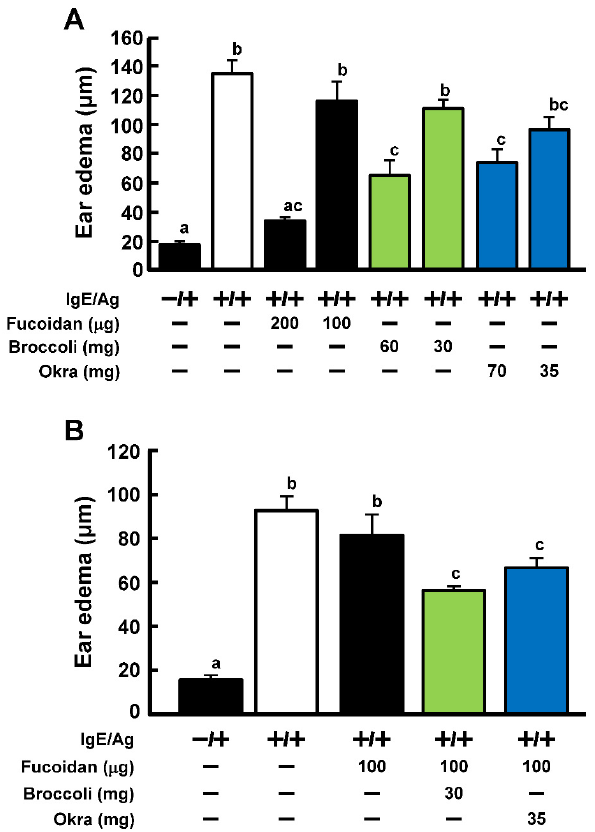
Figure 5. Anti-allergic activity of extracts from broccoli and okra in PCA reaction. ( A ) To determine the amount of each sample alone that did not possess an anti-allergic activity, mice were orally administered fucoidan, broccoli or okra extract for 4 days. ( B ) Mice were orally administered fu- coidan and broccoli or okra extract for 4 days. After administration, PCA reactions were performed. Ear edema was evaluated 2 h after antigen challenge. Values represent the means ± SE of 5 mice in each group. Different superscript letter (a, b, c) means the significant differences ( p < 0.05; Tukey- Kramer test).